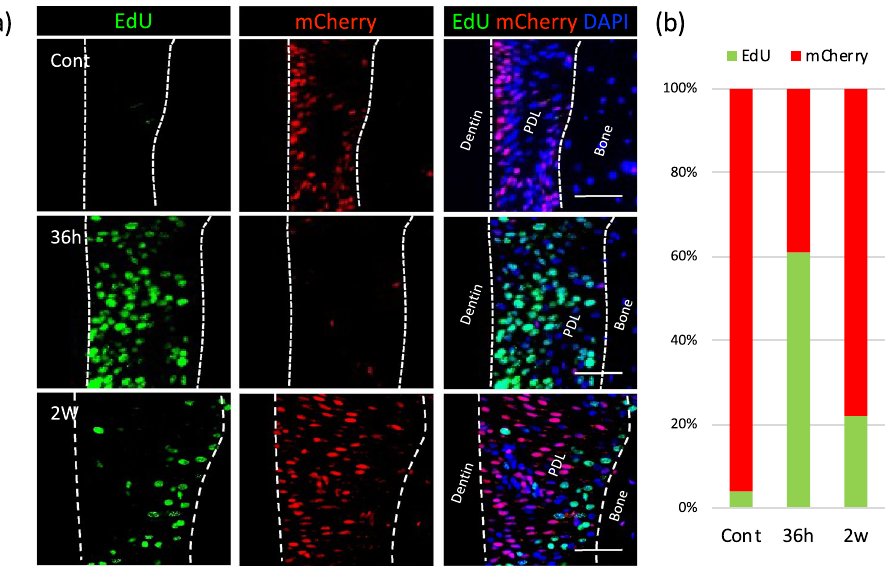
Figure 2. Cell cycle status of PDL cells during OTM. ( a ) Changes in cell cycle status were visualized using Fucci2 mice injected with EdU. The majority of the PDL cells expressed mCherry (red) in control, indicating their status in the quiescent phase. At 36 h, the quiescent cells (red) decreased dramatically, corresponding to increases in proliferating cells (green). At 2 weeks, the majority of the cells returned to the quiescent phase while proliferative activity persisted in some cells. Bar: 50 μm. ( b ) Cell cycle profile showing temporal changes in PDL cell-proliferative activity during